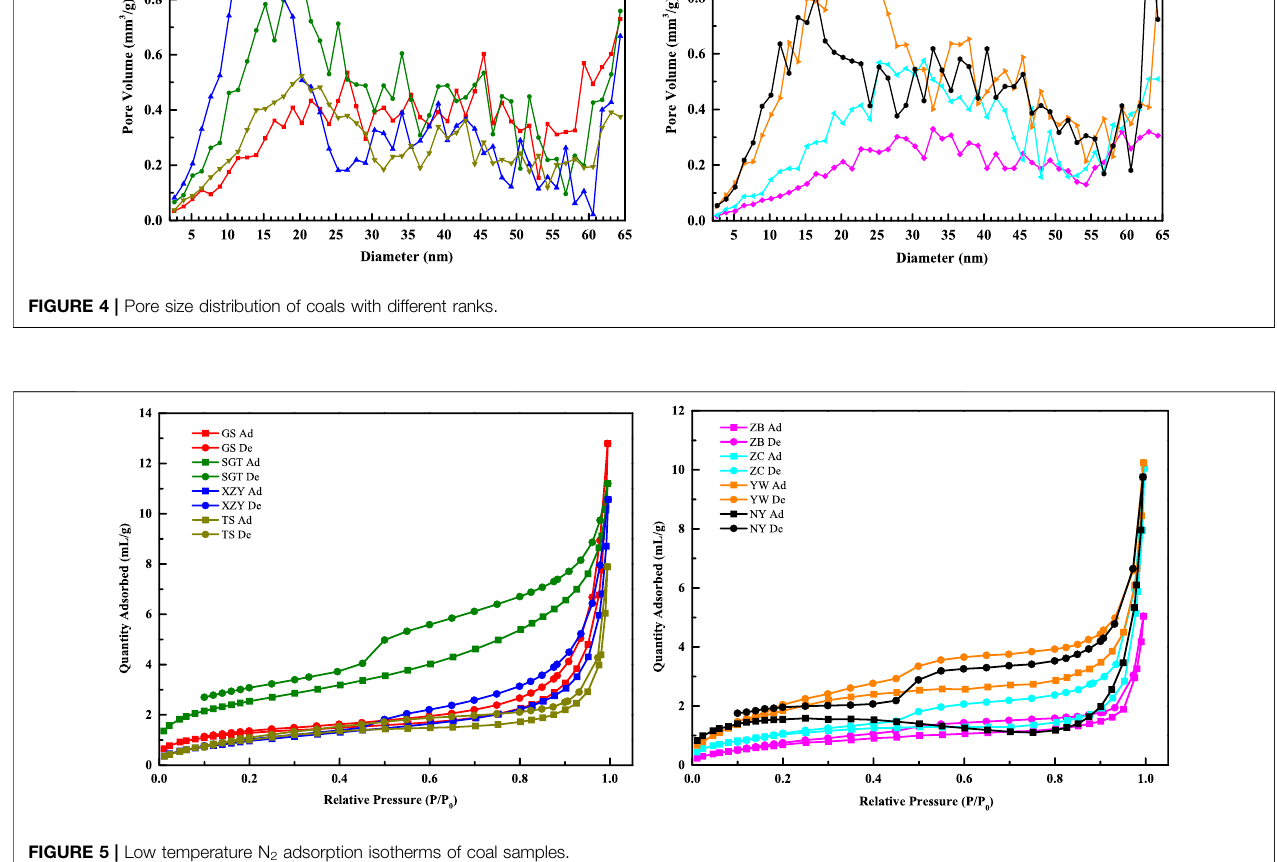
FIGURE 5 | Low temperature N 2 adsorption isotherms of coal samples.